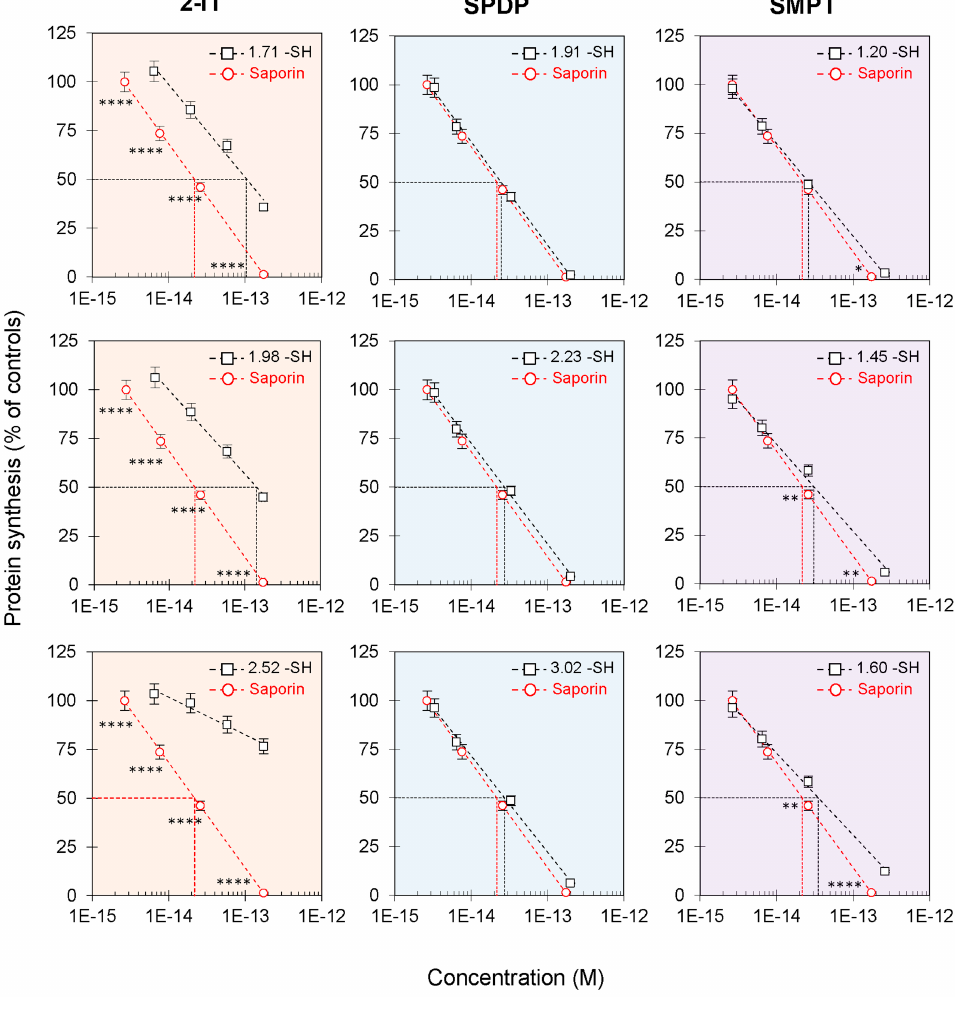
Figure 1. Protein synthesis inhibition assay of derivatized saporin. The inhibitory activity of saporin, native (red) and derivatized with 2-IT, SPDP or SMPT (black), was evaluated using a cell-free protein synthesis system consisting of rabbit reticulocyte lysate. The concentration causing 50% inhibition of protein synthesis (IC 50 ) was calculated by linear regression analysis. Results are expressed as percentage of untreated control samples as means ± SD of three different experiments, each conducted in duplicate. SD never exceeds 10%. Data were analyzed by ANOVA test (confidence range 95%; * p < 0.05, ** p < 0.01, **** p < 0.0001 derivatized saporin versus native saporin).